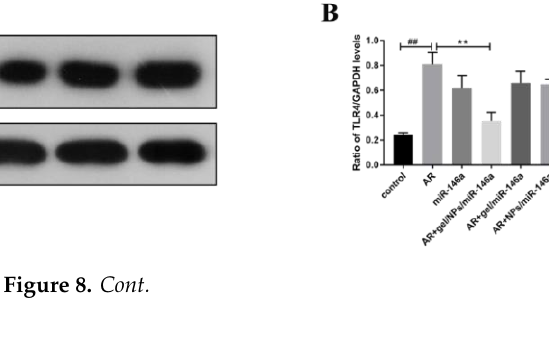
Figure 8. The protein bands of TLR4 ( A , B ) and NF-KB ( C , D ) normalized to GAPDH in nasal mucosa determined by Western blot analysis. Data represent the mean ± SD of three independent experiments. ## p < 0.01 compared with the control group; ** p < 0.01 compared with the AR group. 3.10. HE Staining The changes in the histopathological tissue of the nasal mucosa also reflect the success of the modeling (Figure 9). Observation results with 400× light microscopy showed that the overall structure of the nasal mucosa in the normal group was normal and eosinophil and inflammatory cell infiltration were not observed in the lamina propria; however, there was a large number of inflammatory cells infiltration in the model group. The AR + gel-NPs-miR146a rats’ HE results were consistent with histamine release and were also the best performing group among each of the treatment groups. The overall structure of the nasal mucosa in the AR + gel-miR146a group and AR + NPs-miR146a group did not change significantly, but the individual lamina proprias did. There was rare focal inflammatory cell infiltration. Compared with the nude miR-146a group, the binary preparation and the other two monophyletic formulations showed significantly reduced pathological changes in the nasal mucosa in rhinitis model rats. In summary, the pathological results showed that the AR + gel-NPs-miR146a group could significantly reduce the pathological changes i006E the nasal mucosa. Moreover, the AR + NPs-miR146a and AR + gel-miR146a groups had similar pathological effects and improved the nasal mucosa damage caused by allergic rhinitis. The AR + NPs-miR146a group seemed to cause less inflammation, while the AR + gel-miR146a group had improved nasal mucosal cells.